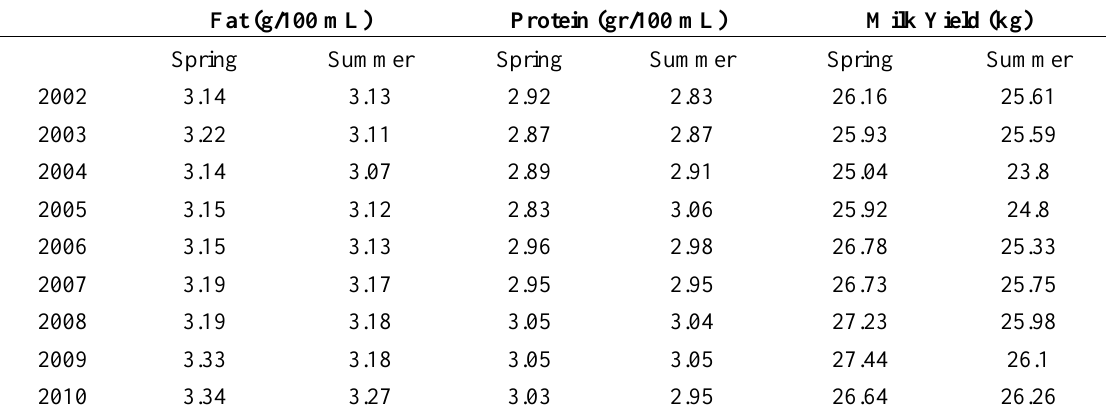
Table 2. Seasonal averages of fat, protein, and milk yield (Kg) of Holstein cows in spring and summer from 2002 to